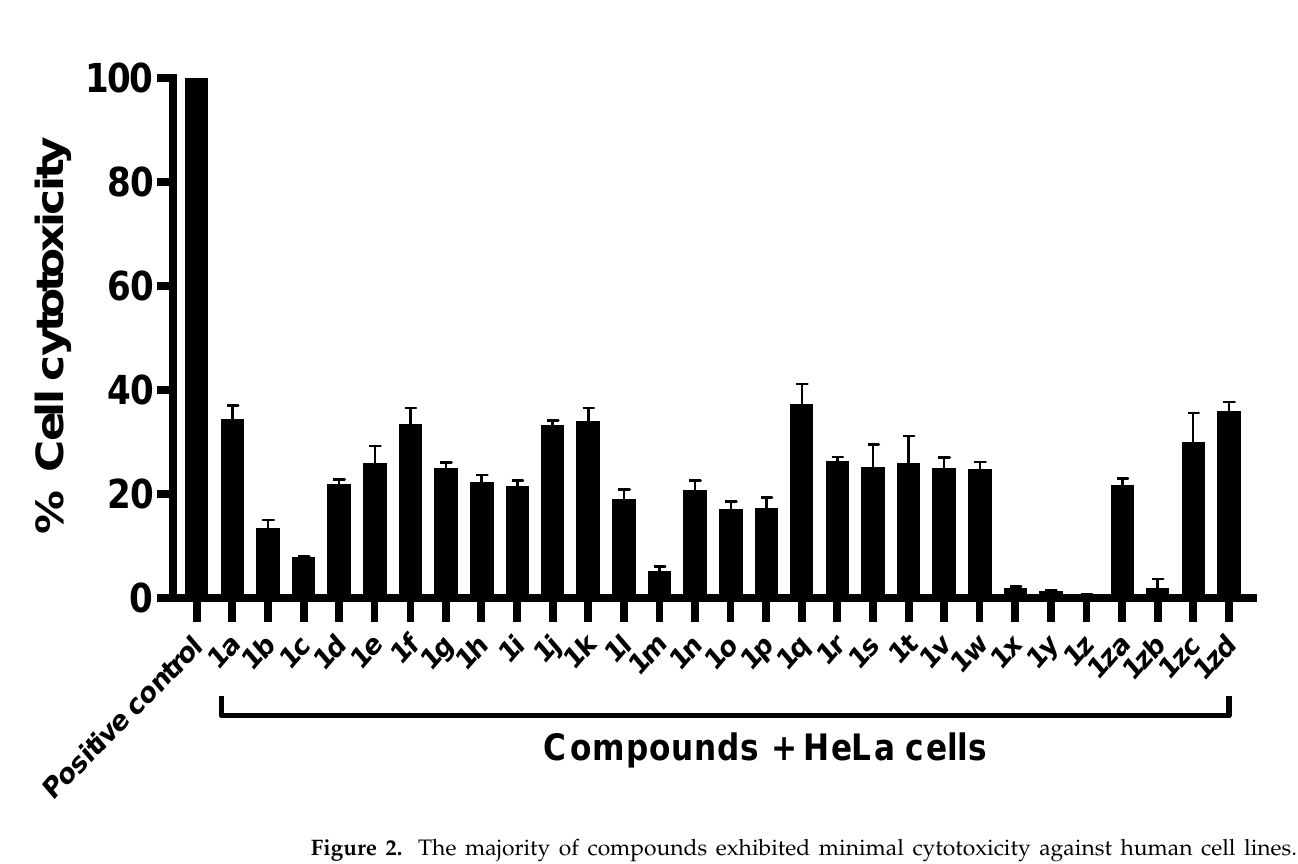
Figure 2. The majority of compounds exhibited minimal cytotoxicity against human cell lines. Confluent monolayers of HeLa cells were treated with 50 µM of the compounds. The compounds 1o, 1l, 1p, 1m, 1c, 1b, 1zb, 1z, 1y , and 1x were non-toxic, whereas the compounds 1r, 1s, 1t, 1zc, 1q, 1n, 1a, 1h, 1i, 1f, 1g, 1e, 1j, 1d, 1k, 1v, 1za, 1w, and 1zd exhibited limited cytotoxicity against human cells.